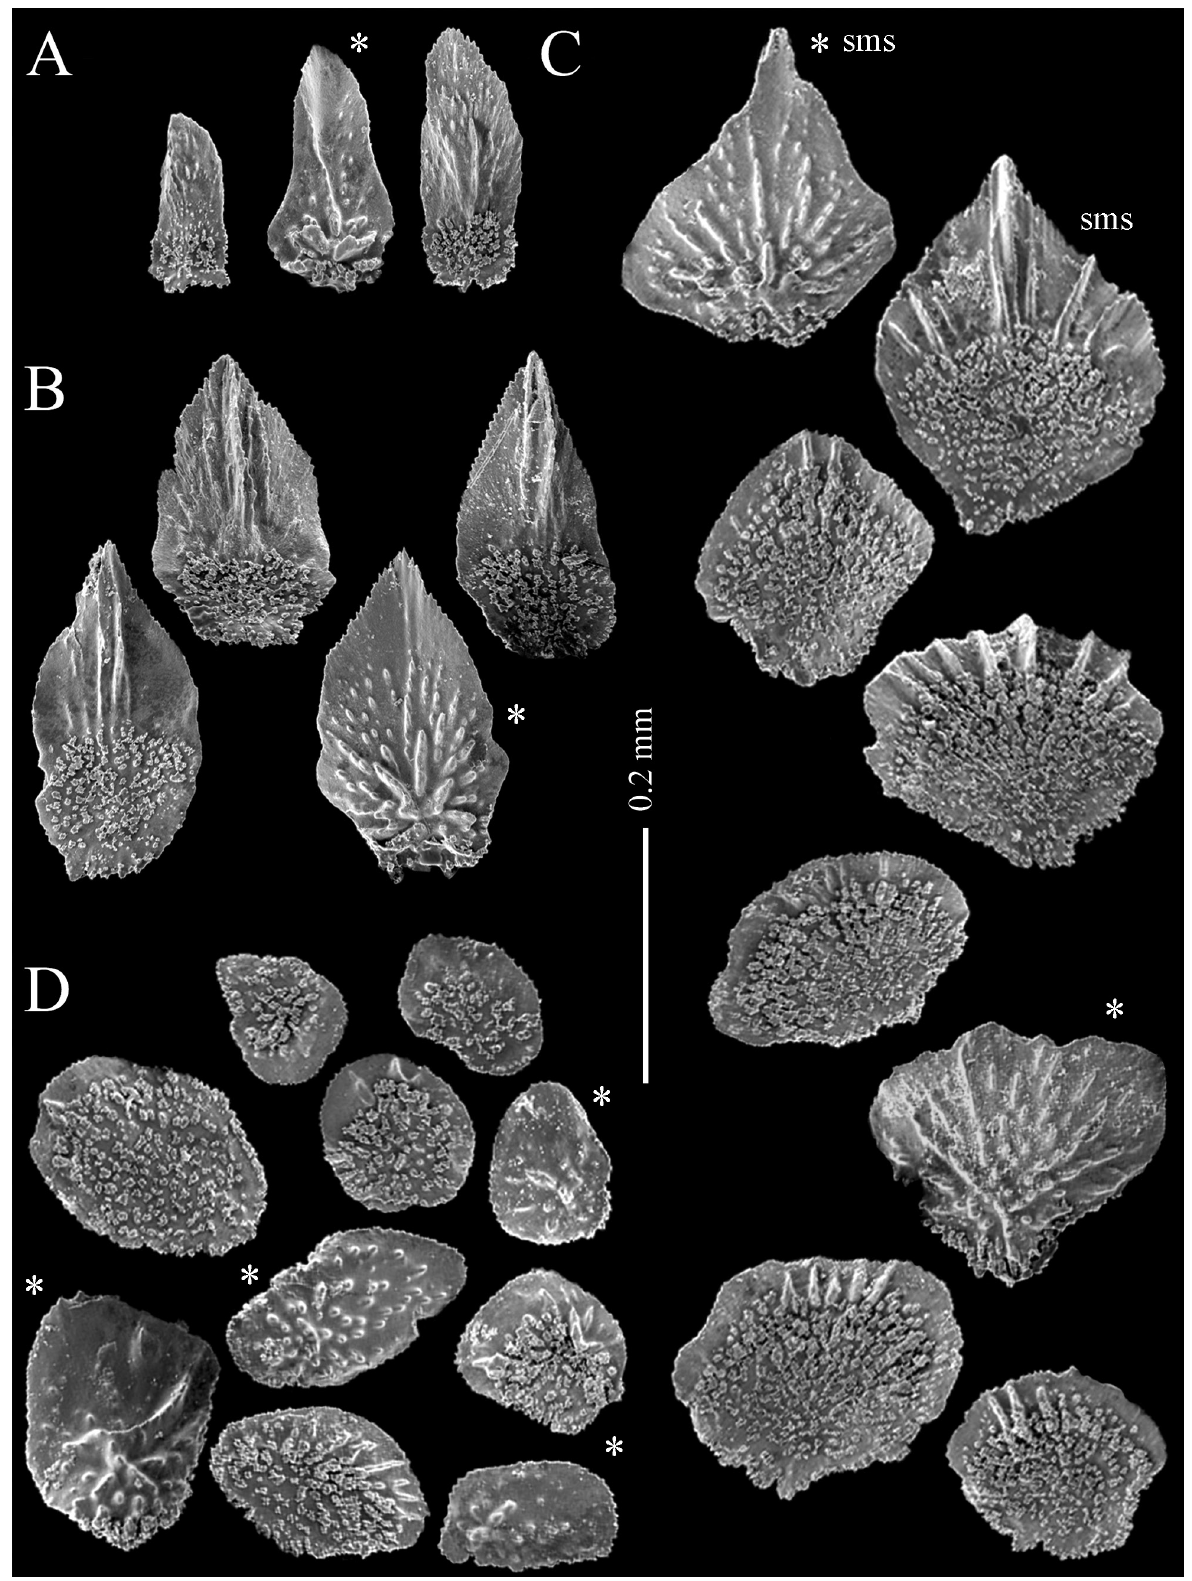
Fig . 17. – Thouarella vitjaz n. sp., holotype (IORAS IV-9-Alc-010-002): A, opercular scales; B, marginal scales; C, body scales; D, coenen- chymal sclerites. [*outer surface view; sms=submarginal